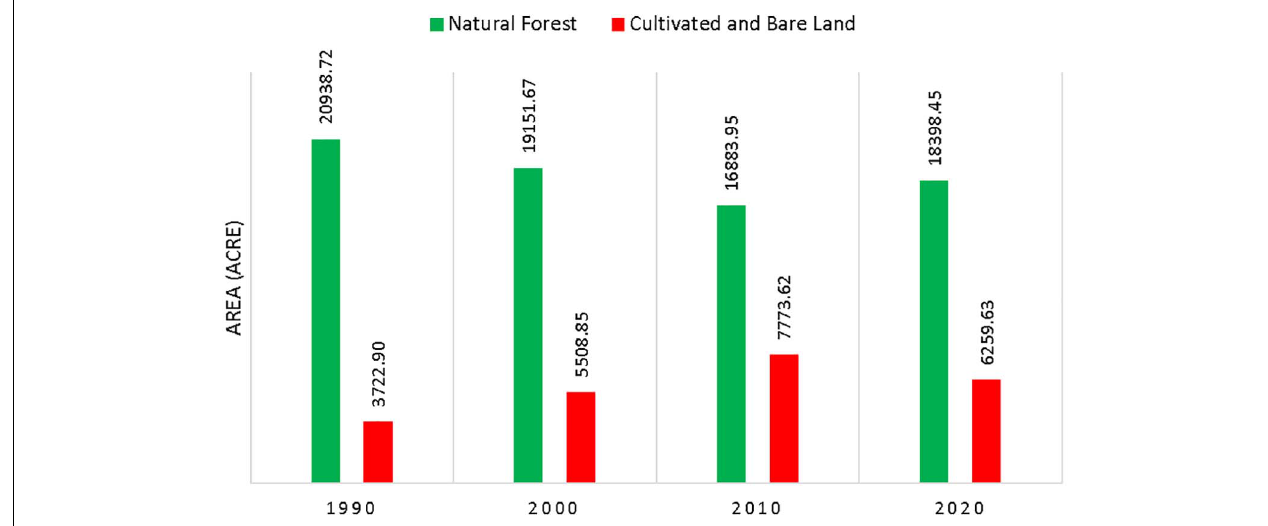
FIGURE 3 | Forest land area (acre) changes in DDWS since 1990 to 2020.